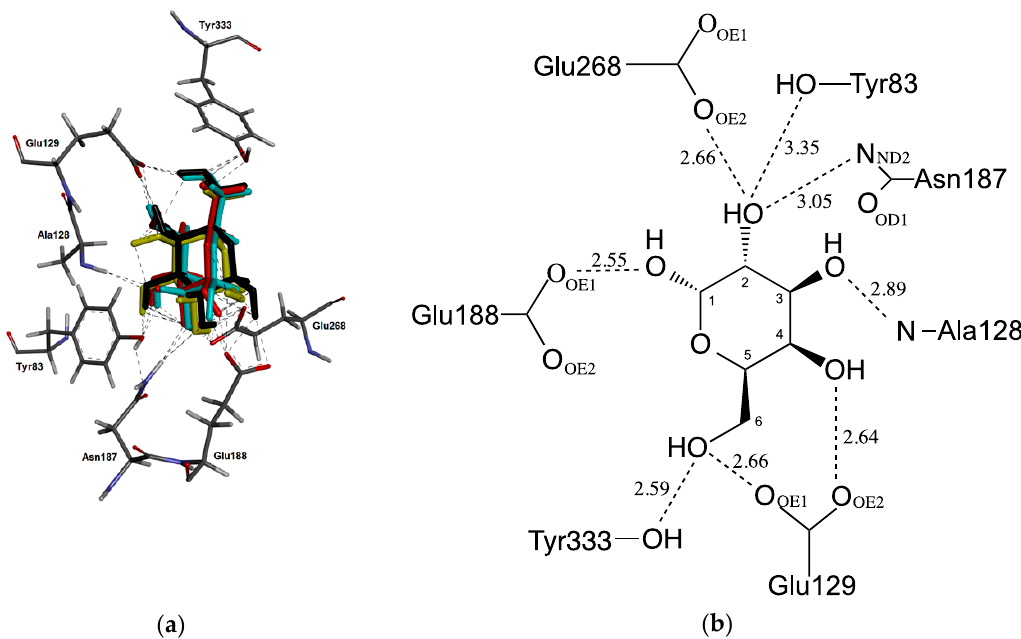
Figure 3. ( a ) Top galactose poses obtained in early termination runs with the various scoring functions used, superimposed on the one observed in the crystal structure, drawn in yellow. The ChemScore structure is drawn in red, while the GoldScore and ChemPLP are drawn in black and cyan, respectively. ( b ) Hydrogen bond interactions between the ligand and the protein residues, resulting from the GoldScore scoring protocol run, observed as well in PDB entry 3THC [32].